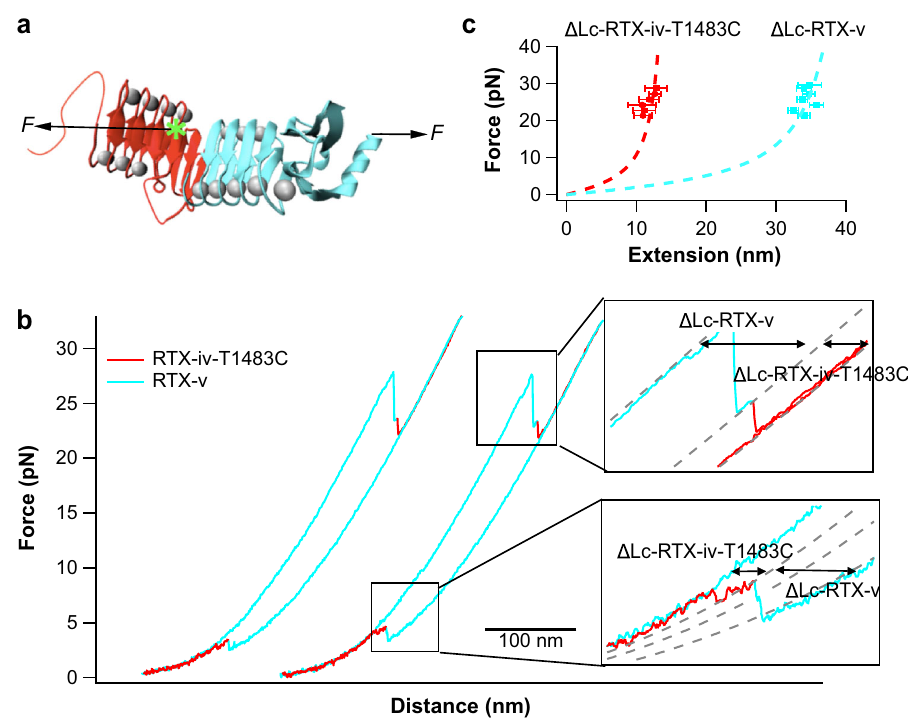
Fig. 6 Mechanical unfolding/folding of RTX-iv-T1483C-v. a Schematics of stretching RTX-iv-T1483C-v from its C-terminus and the residue 1483 (indicated by the green asterisk). b Representative force – distance curves showing the unfolding/folding of RTX-iv-T1483C-v at a pulling speed of 50 nm/s. The unfolding/folding of RTX-iv-T1483C is colored in red, and the unfolding/folding of RTX-v is colored in cyan. Both unfolding and folding initiate from RTX-v. c The WLC fi tting of the unfolding of force – extension relationships of the unfolding of RTX-iv-T1483C (red) and RTX-v (cyan), respectively. The WLC fi ts yielded a Δ L c of 16.1 ± 0.3 nm ( n = 105) for RTX-iv-T1483C, and Δ Lc of 45.2 ± 0.7 nm ( n = 105) for RTX-v, respectively. The error bars indicate standard